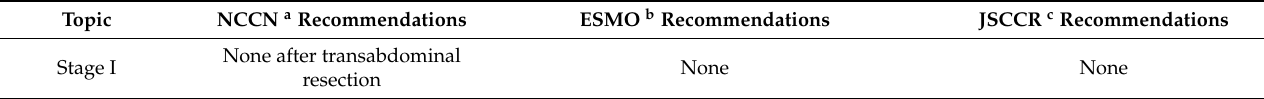
Table 4. Rectal cancer: Adjuvant